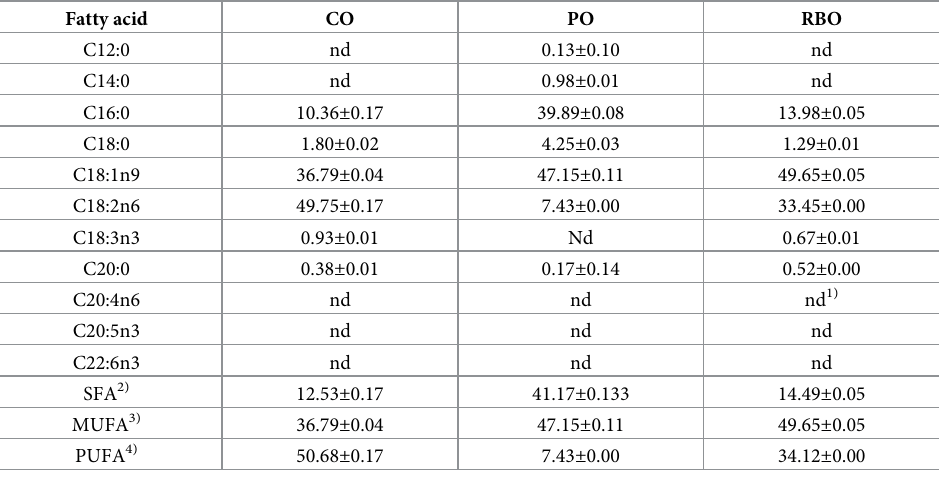
Table 3. Fatty acid composition in the vegetable oils (g /100 g total fatty acids). Fatty